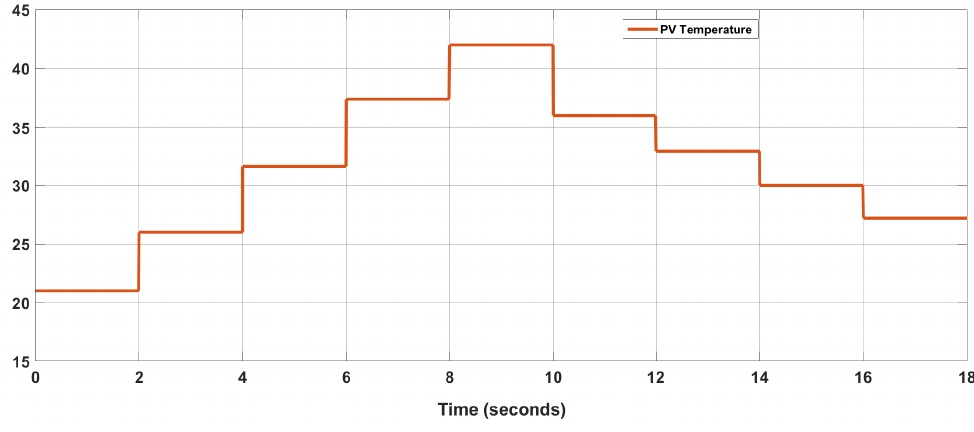
Figure 4. Varying Temperature ( ◦ C) of PV.